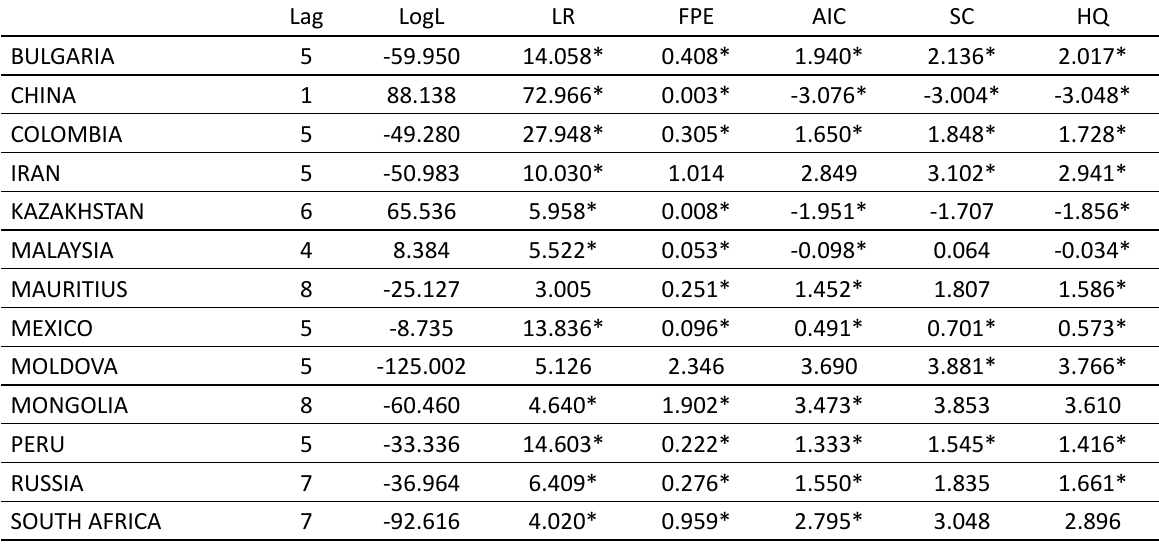
Table 3: Lag Length Selection For Middle Income